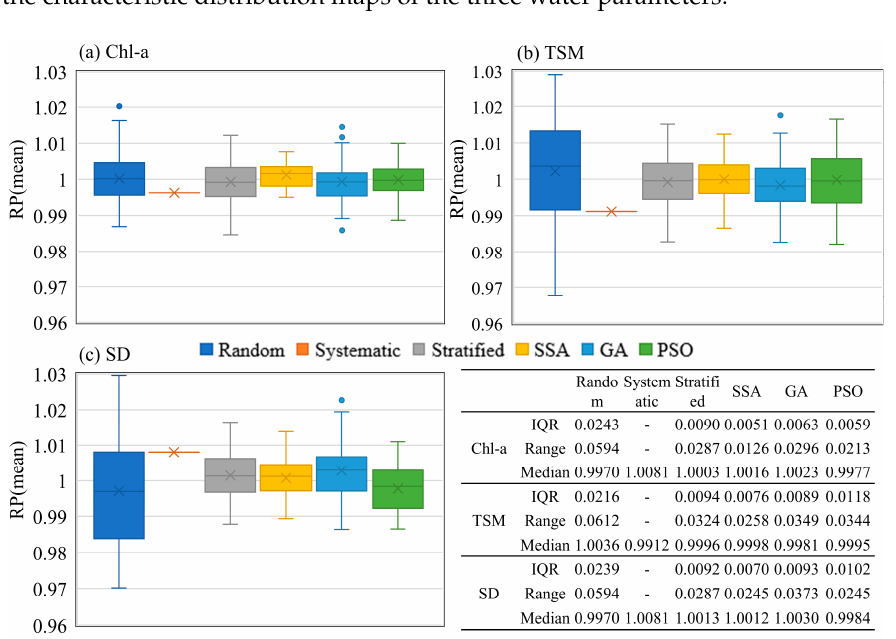
Figure 6. Boxplots of RMSE for 100 simulations for each sampling method, Chl-a ( a ), TTS ( b ), SD ( c ).